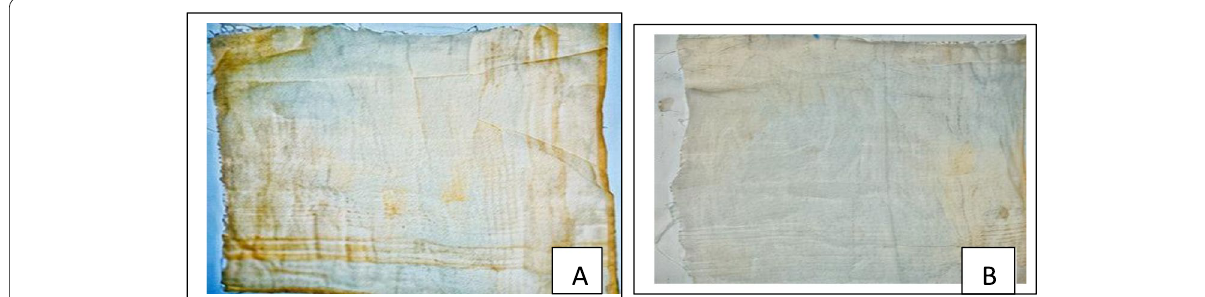
Fig. 6 Wash performance of crude amylase of P. tuberregium on equally stained fabric (sand). A Water-washed fabric. B Cleaner fabric using crude amylase after 10 min